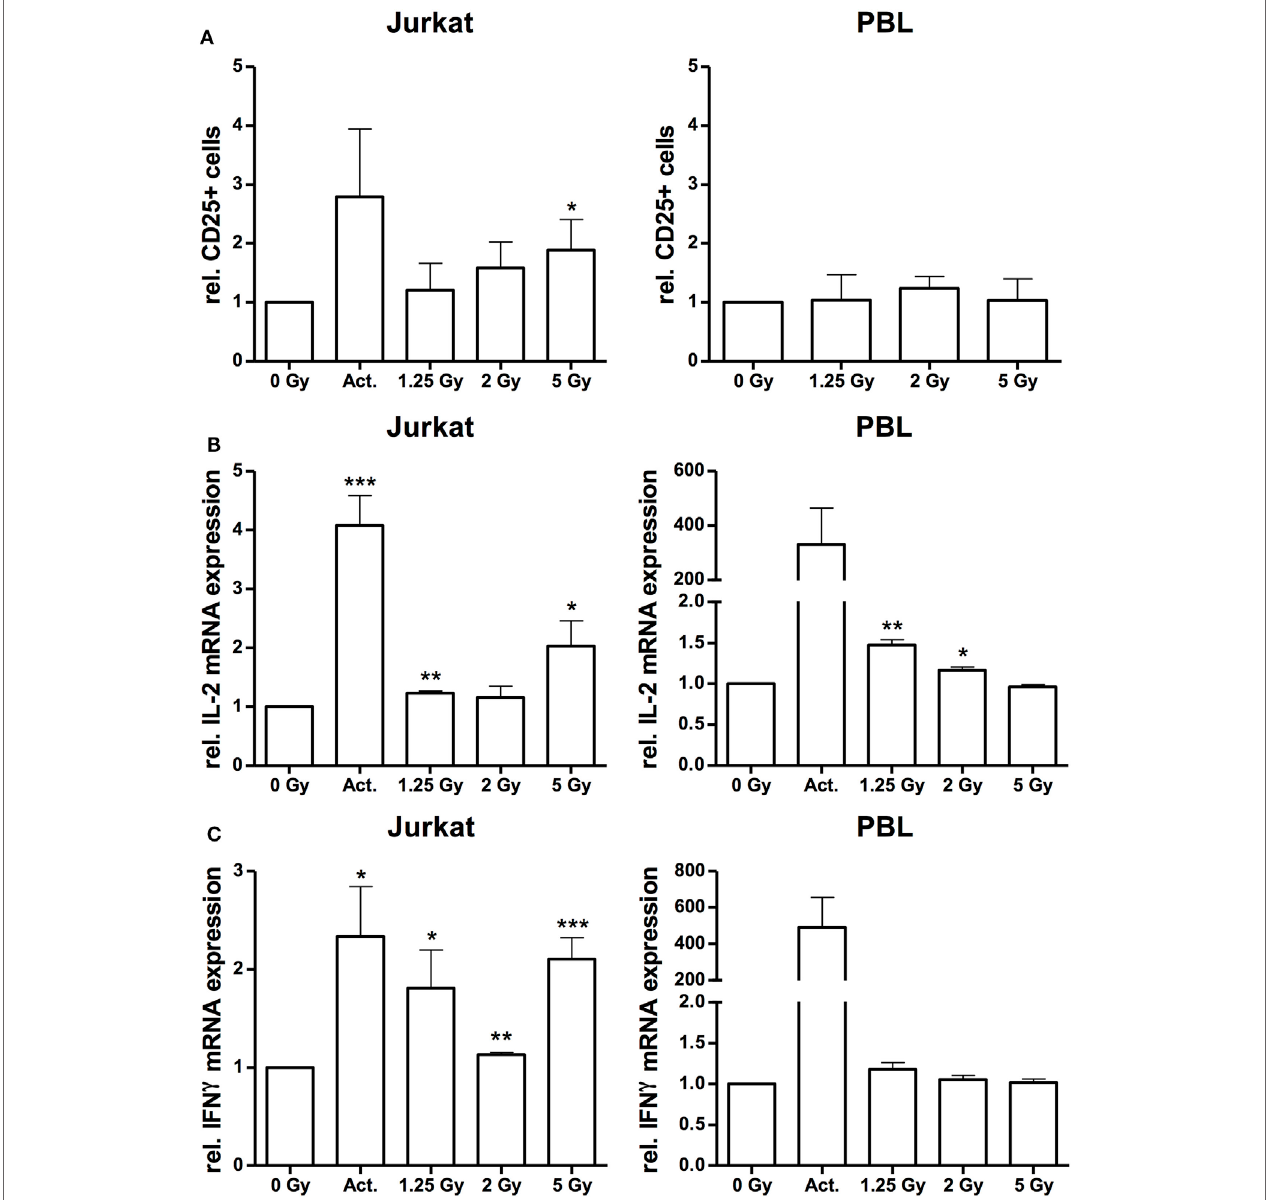
FigUre 6 | Irradiation stimulates immune activation in Jurkat cells and peripheral blood lymphocytes (PBL). FACS analysis of CD25 surface expression on Jurkat cells and CD3-positive PBL (a) following irradiation with a dose of 1.25, 2, and 5 Gy. Stimulation with 25 µl/ml CD3/CD28/CD2 T-cell activator (Act.) in Jurkat cells or mock-irradiated cells served as controls ( N = 3). In PBLs, an activator could not be applied due to inference with the CD3 stimulus. Quantification of interleukin (IL)-2 (B) and interferon- γ (IFN γ ) (c) mRNA expression by quantitative real-time PCR in Jurkat cells and PBL at 24 h after irradiation with a dose of 1.25, 2, or 5 Gy. Stimulation with 25 µl/ml CD3/CD28/CD2 T-cell activator (Act.) or mock-irradiated cells served as controls ( N = 2). Data are represented as mean + SD. Student’s t -test compared activator-treated or irradiated cells with non-irradiated controls; * P < 0.05, ** P < 0.01, *** P <